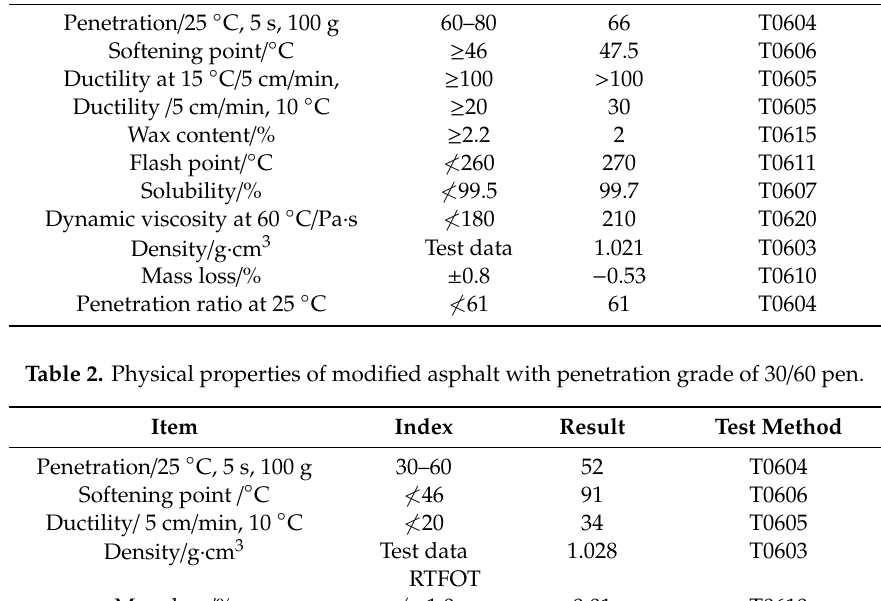
Table 1. Physical properties of asphalt with penetration grade of 60 / 80 pen.